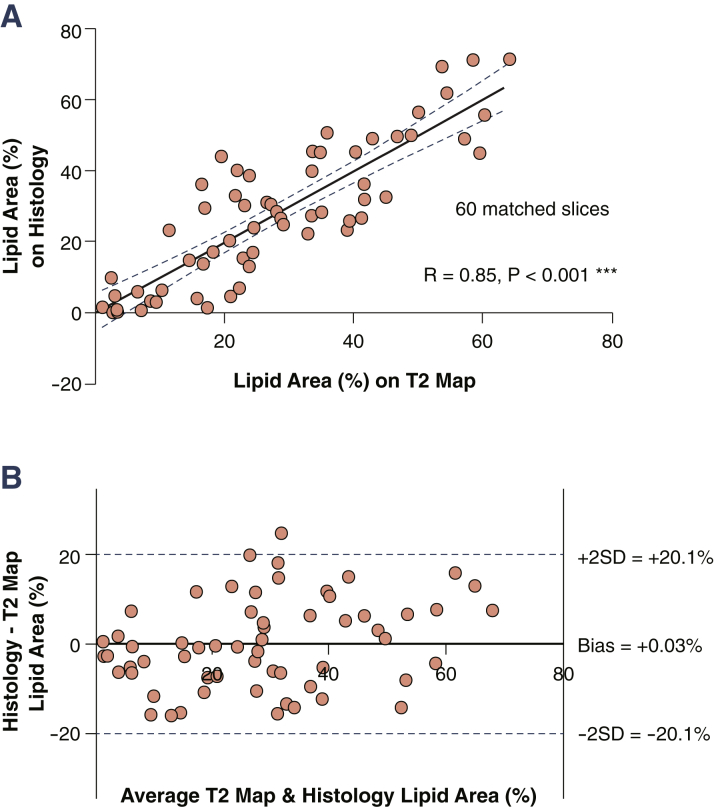
Correlation of Lipid Area Between T2 Mapping and Histology(A) Scatter plot of lipid area (%) by slice location showed excellent correlation (R = 0.85, p < 0.001). (B) Bland-Altman analysis showed good agreement between histology and T2 map with minimal bias.